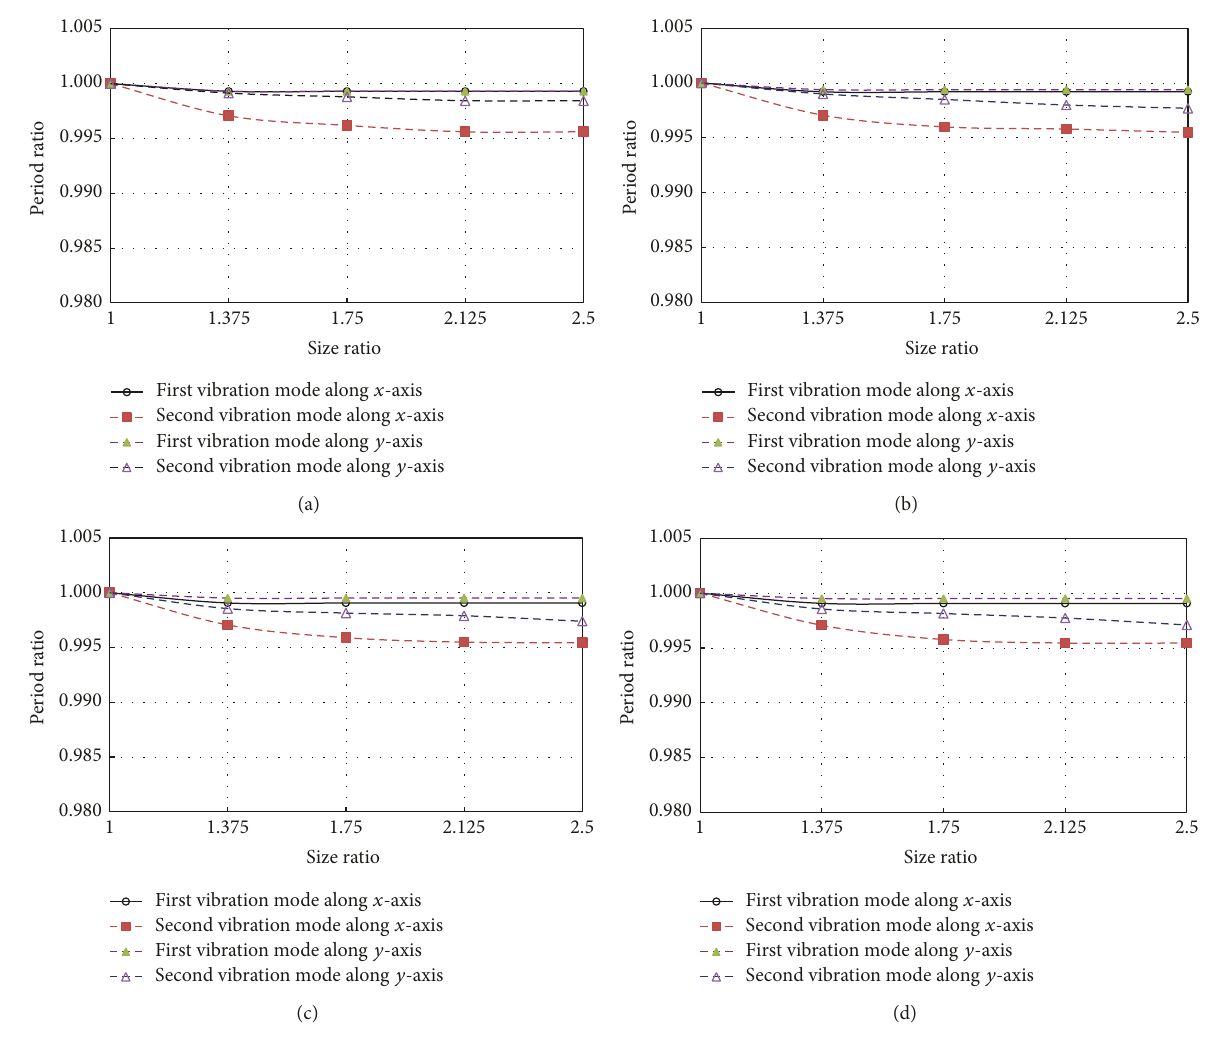
Figure 10: Computed mode period ratios, corresponding to a water level, 𝐻 w = 1.8 m, as a function of the size ratio of the water tank: (a) without tip mass; (b) with a tip mass of 12.1kg; (c) with a tip mass of 23.4 kg; (d) with a tip mass of